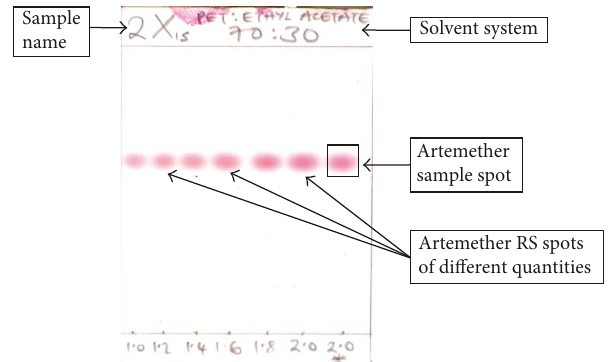
Figure 1: A sample of a developed TLC plate of an artemether- containing